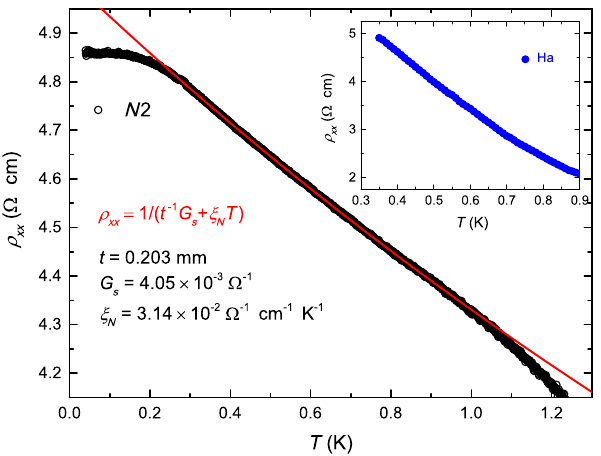
FIG. 9. Resistivity ρ of sample N 2 as a function of the xx temperature below T ¼ 1 . 3 K measured in a dilution refrigerator. Between 0.3 and 1.0 K, ρ of sample N 2 can be fitted by ρ xx ð G s =t þ ξ N T Þ − 1 (see text) (solid line). The fitting parameters are also shown. The inset shows the low-temperature resistivity of YbB 12 sample